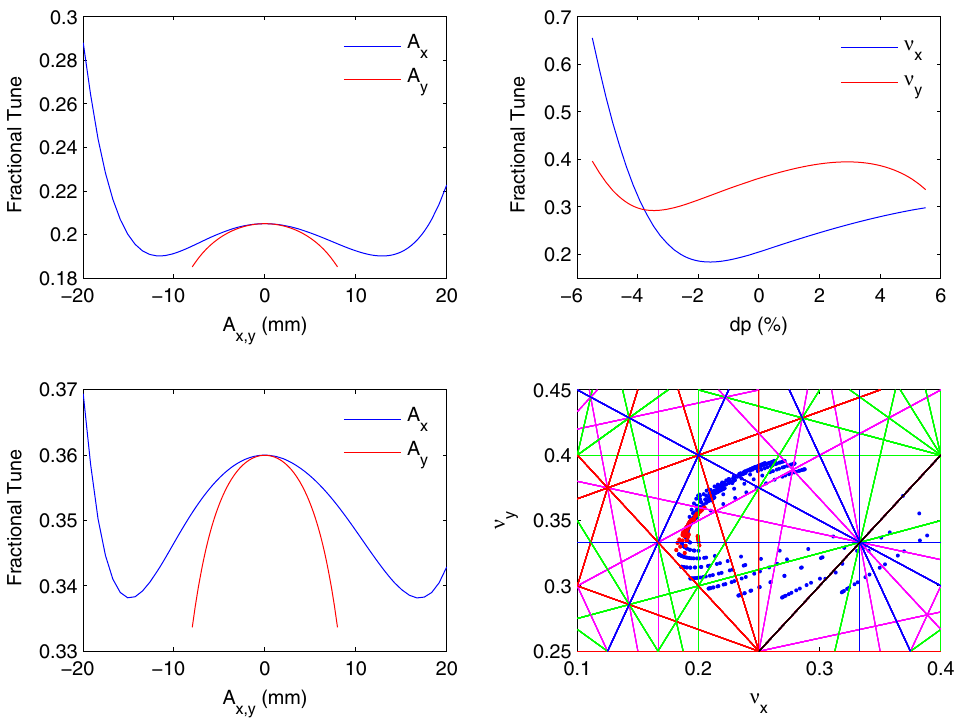
FIG. 2. Horizontal detuning with amplitude (top left), vertical (bottom left) and detuning with momentum (top right). Tune footprint for Diamond (bottom right) computed on the grid extending to ½ ˆ x; ^ y (cid:2) ¼ ½ 15 ; 6 . 5 (cid:2) mm (in red) and ½ ˆ x;